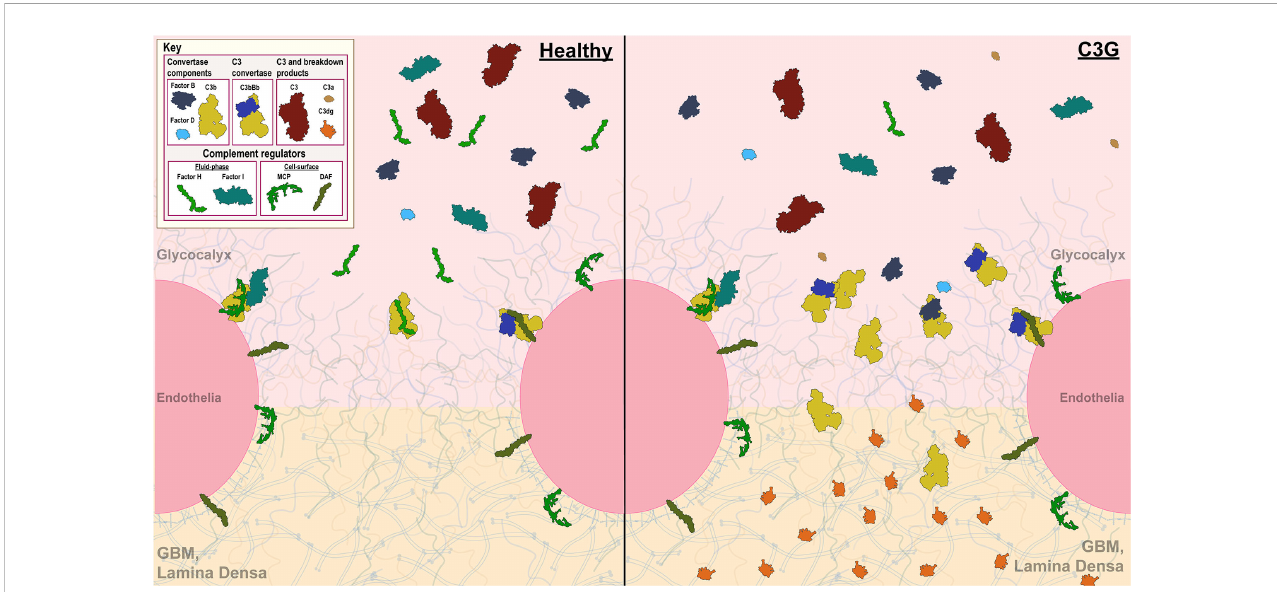
FIGURE 1 Complement control in the glomerular microenvironment. The glomerulus is the fi ltration unit of the kidney. Its fi ltration barrier is composed of the glycocalyx, glomerular endothelial cells (GEnC), glomerular basement membrane (GBM) and podocytes. The glycocalyx, a network of proteoglycans and glycoproteins, overlays highly fenestrated GEnCs. GEnC pores comprise ~20-50% of total cell surface area (11 – 16), allowing fi ltration of waste products through the glycomatrix (glycocalyx and the GBM), underlying podocytes and further into the Bowman ’ s capsule to be excreted as urine. Complement activity on GEnCs is controlled by both cell-bound (MCP and DAF depicted) and fl uid-phase complement regulators (Factor H (FH) and Factor I (FI) depicted), while complement control over the GEnC pores relies on fl uid-phase regulators alone. A healthy glomerular microenvironment exhibits adequate cell-surface and fl uid-phase complement control thereby preventing injury to the GEnCs and complement deposition in the glycomatrix. In contrast, in the C3G glomerular microenvironment, fl uid-phase complement dysregulation occurs (an example of C3G driven by FH de fi ciency depicted) in presence of adequate cell-surface complement control. Here, GEnCs are still protected by the cell-bound regulators, but the lack of fl uid-phase complement control over the GEnC pores allows complement ampli fi cation and complement deposition to occur as re fl ected by changes in the lamina densa of the